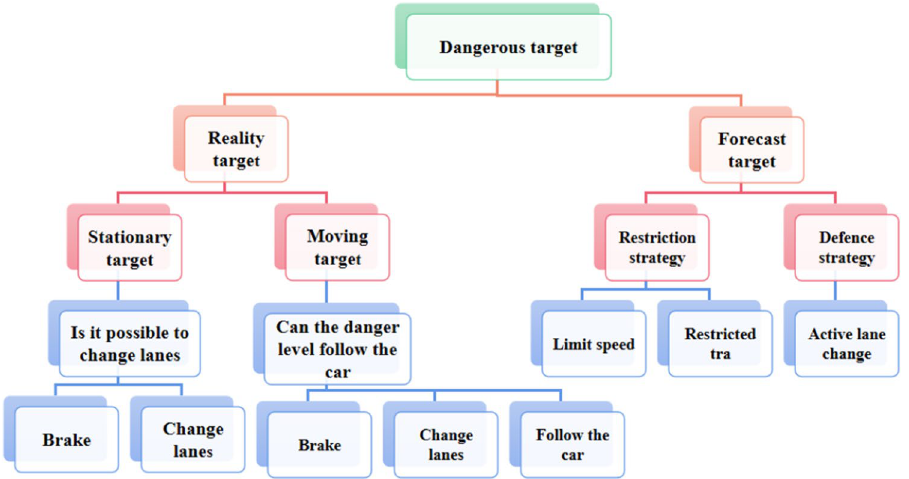
Figure 3. The risk model is used to give the prediction target and risk based on location and accident date, evaluate the target risk index, and then deal with it